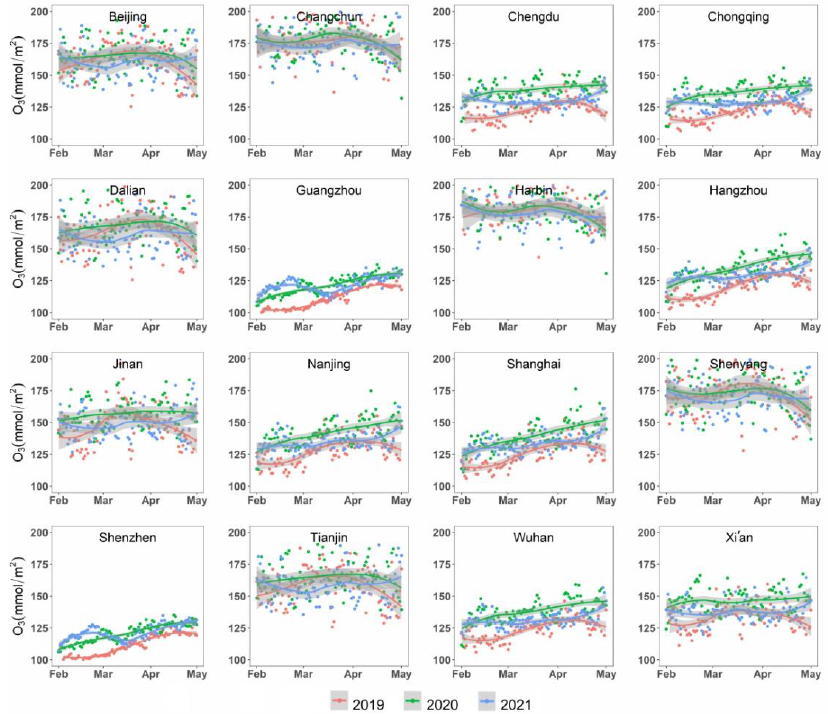
Figure 5. Temporal variation in O 3 concentrations in 16 metropolitan areas from 1 February to 1 May in 2019, 2020, and 2021 across the selected lockdown stages. The dots in red, green, and blue colors indicate the values of O 3 concentration in 2019, 2020, and 2021 respectively. The lines and the shaded grey areas refer to the fitted curves modeled by loess, with its 95% confidence interval.